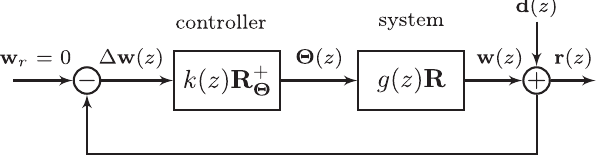
FIG. 1. Schematic of the digital closed orbit feedback system in the generic form. w is the reference orbit, Δ w ð z Þ is the error r signal, Θ ð z Þ is the corrector settings, r ð z Þ is the residual orbit and d ð z Þ is the